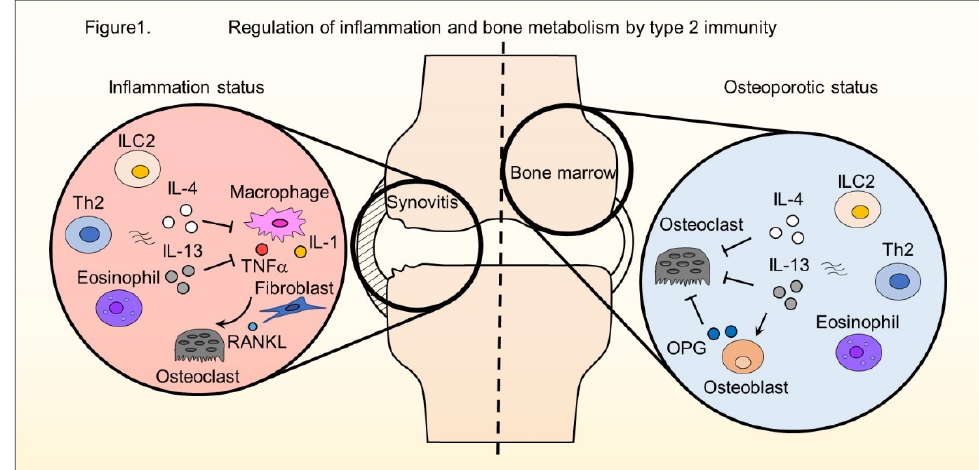
Figure 1. Regulation of inflammation and bone metabolism by type 2 immunity. In an inflammatory status of RA, ILC2s, Th2 cells, and eosinophils exert anti-inflammatory properties in the inflamed joint by producing type 2 cytokines such as IL-4 and IL-13. Type 2 cytokines suppress the production of inflammatory cytokines by macrophages. Activated macrophages secrete proinflammatory cytokines IL-1 and TNF α , which stimulate synovial fibroblasts to express RANKL. Type 2 immunity can modulate bone metabolism by regulating the secretion of inflammatory cytokines. In the bone marrow environment, osteoclasts and osteoblasts regulate bone metabolism. IL-4 and IL-13, which are secreted by type 2 immune cells, control osteoclast differentiation directly and indirectly.